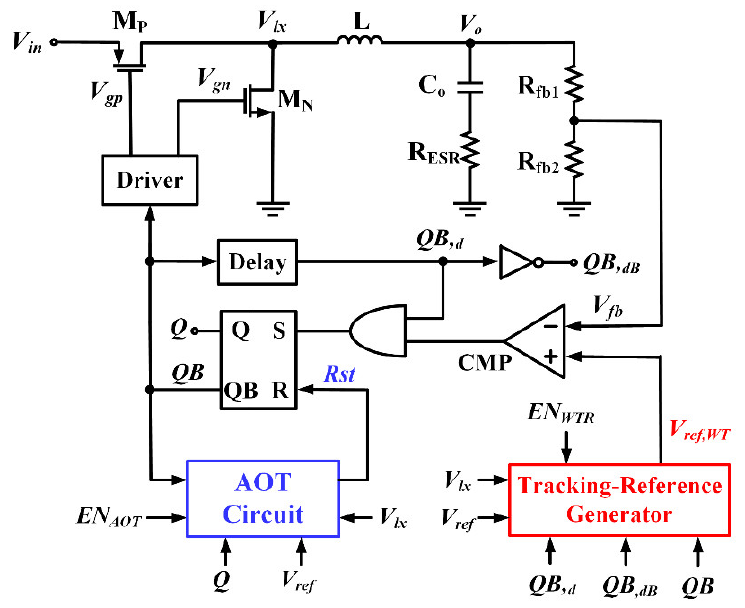
Figure 4. Block diagram of adaptive on-time (AOT) buck converter with wave tracking reference (WTR) control.